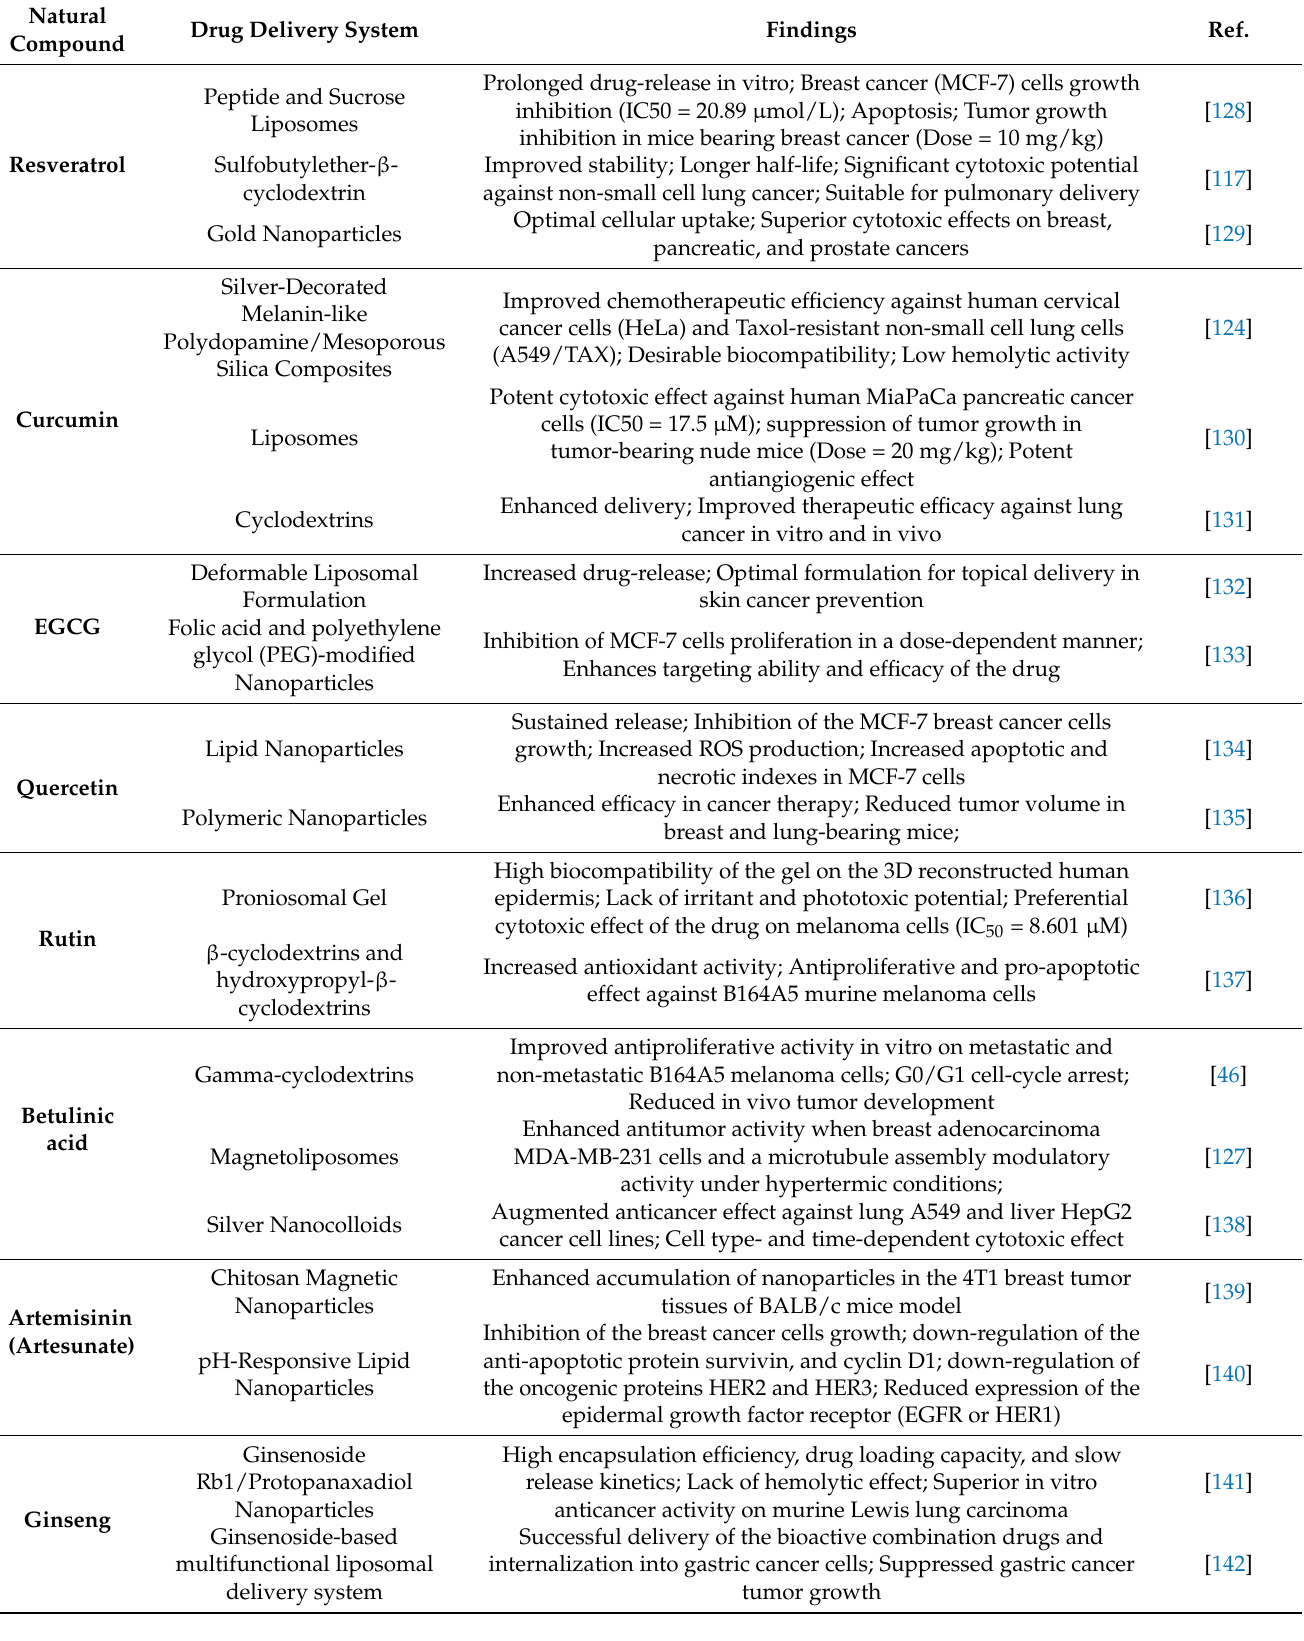
Table 4. Drug delivery systems for the efficient encapsulation and enhanced anticancer effect of natural compounds. Natural